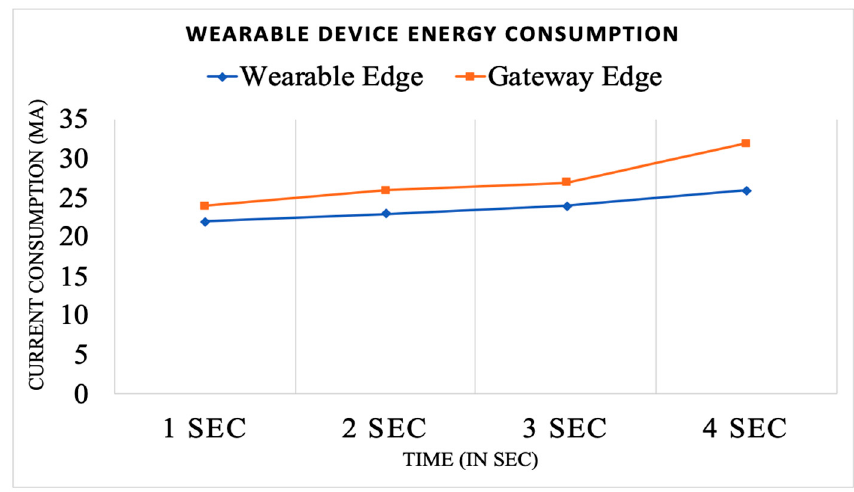
Figure 9. Analysis of sensor wearable energy consumption when processing is taking place at the sensor wearable and gateway edge. Marginal difference in energy consumption due to the available redundancy in the commercial device used.